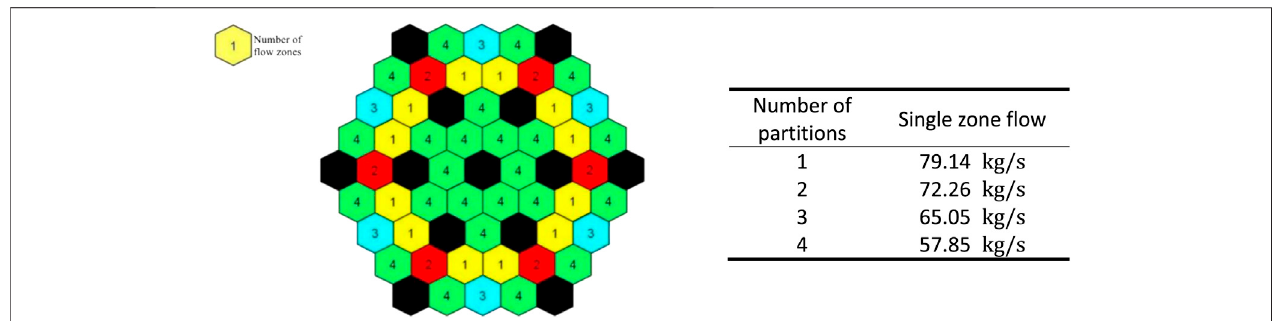
FIGURE 7 | Flow partitioning results for SPALLER-100 (beginning of